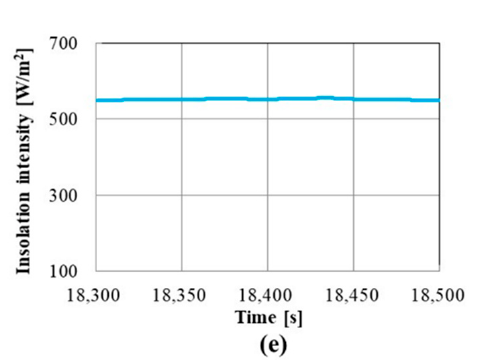
Figure 18. Insolation intensities of the selected regions. ( a ) Case 1. ( b ) Case 2. ( c ) Case 3. ( d ) Case 4. ( e ) Case 5.